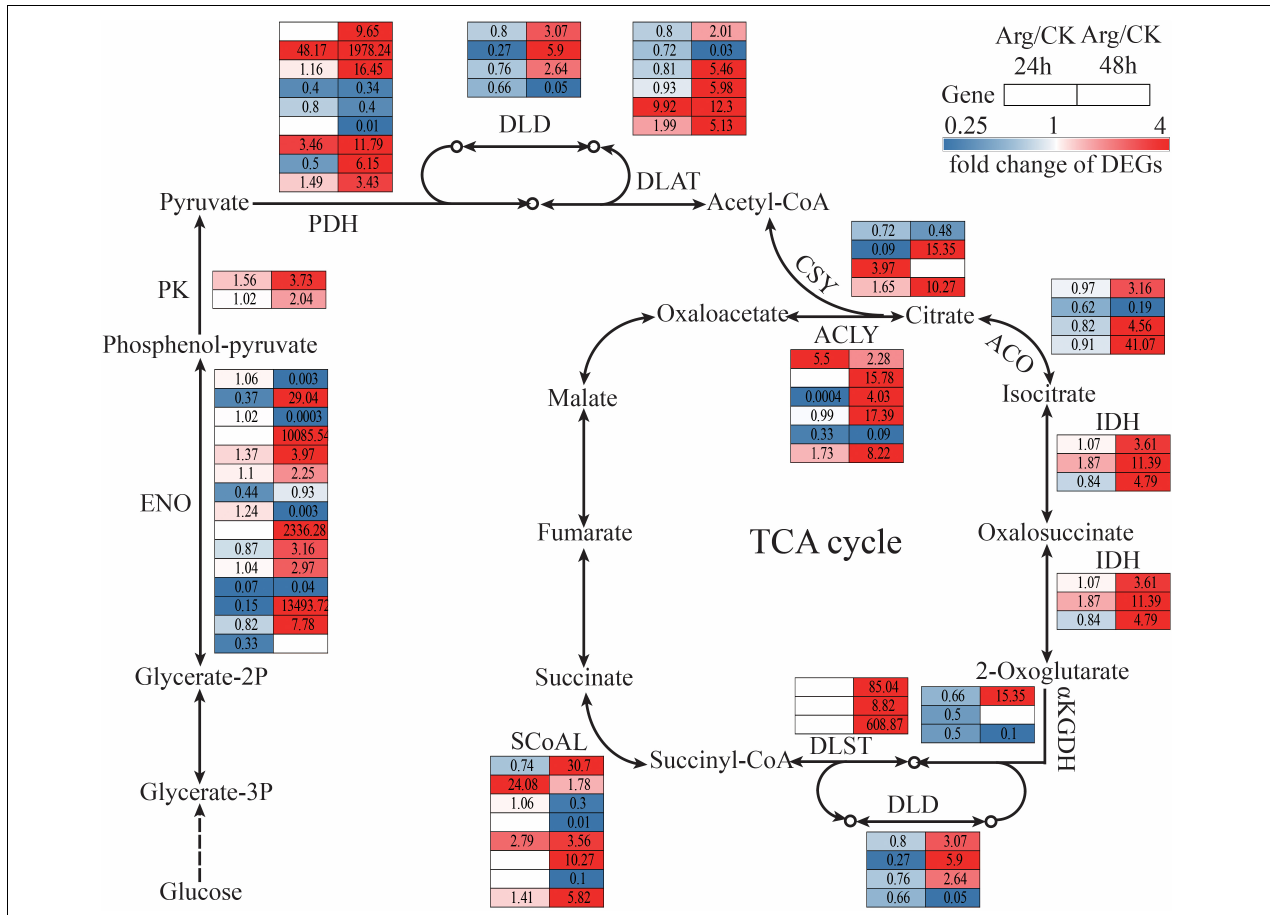
FIGURE 7 | The transcriptomic changes in the glycolysis and TCA cycle. The enzyme codes and corresponding enzyme names were listed in Supplementary Table 6 . The color of red and blue squares represent upregulation and downregulation, separately, while white square means that the unigenes were not expressed in this point. The solid and dotted arrows indicate one-step and poly-step reactions, respectively. The same row represents the abundance change of one unigene at 24 h (left column) and 48 h (right column), the number in each square beside the enzyme code refers to the fold change of corresponding DEGs. Red and blue squares indicate upregulation and downregulation, separately, while white means are not expressed at this time point. DEGs, differentially expressed